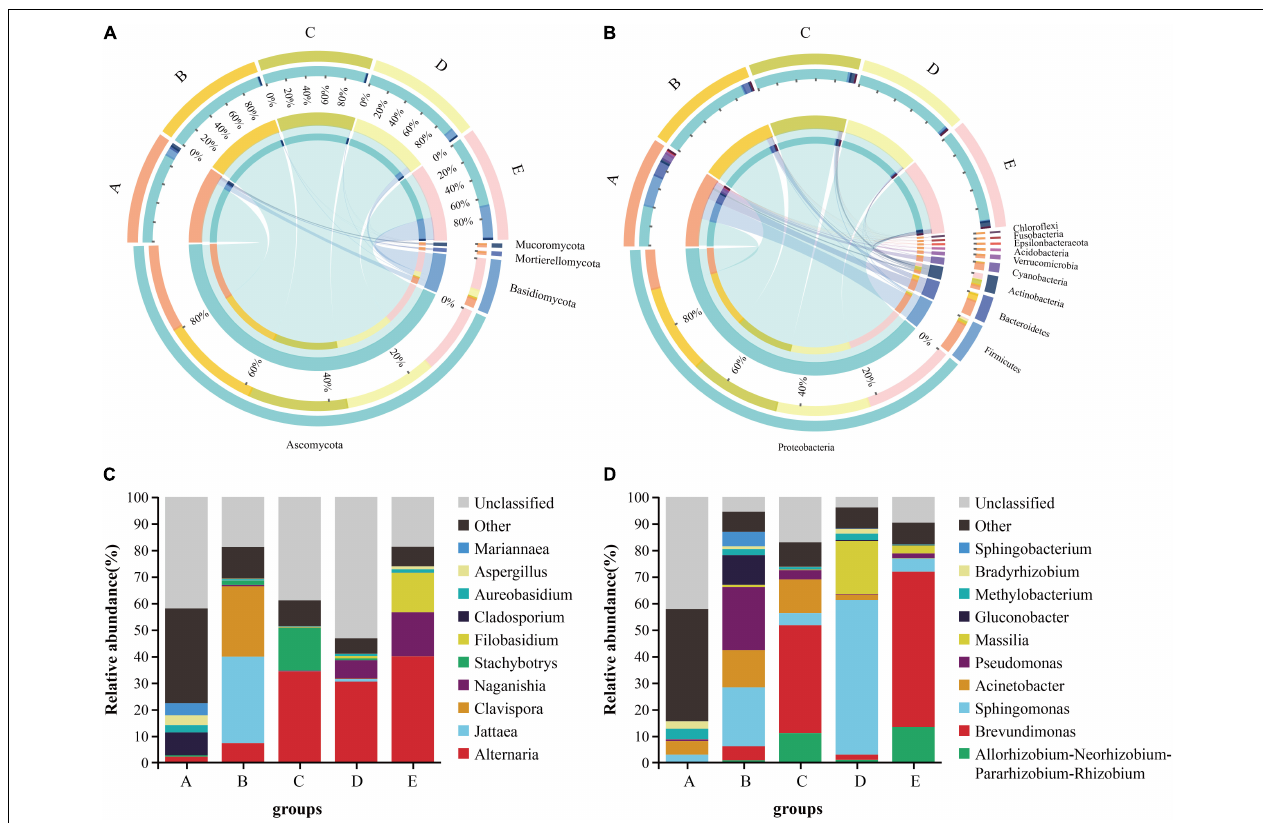
FIGURE 2 | The differences in the microbial communities of Cabernet Sauvignon grapes at different growth stages. The difference between fungi (A) and bacteria (B) communities at the phylum level (relative abundance > 0.01%). The relative abundance of fungi (C) and bacteria (D) communities at the genus level (Shown top10). A, fruit setting; B, early veraison; C, end veraison; D, mid maturity; E, harvest.